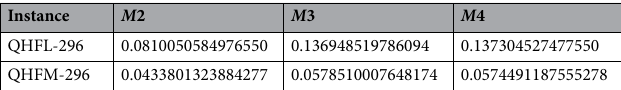
Table 2. JSD-sensitivity test